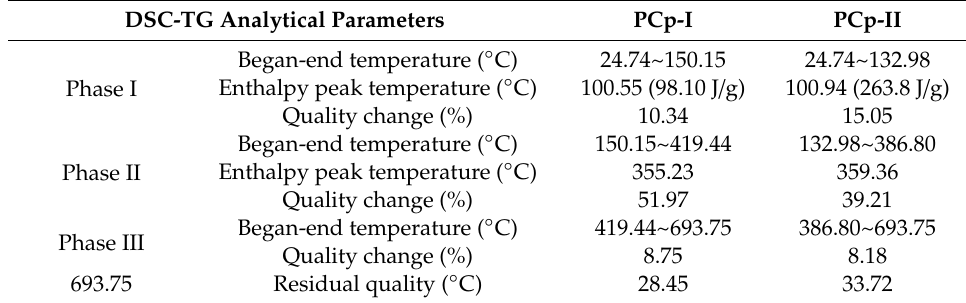
Figure 7. gravimetric and differential scanning calorimetric analysis of PCp-I and PCp-II. Table 7. The thermal gravimetric and differential scanning calorimetric analysis results of PCp-I and